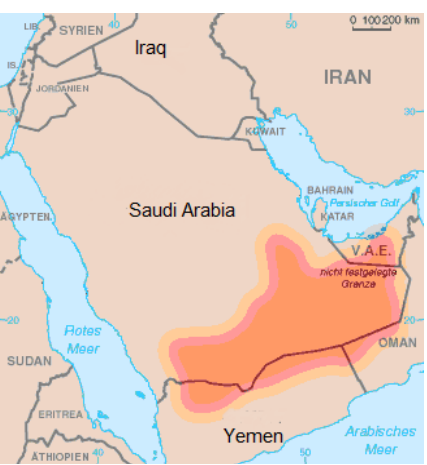
Fig. 10. Rub’al Khali (colored red) is one of the most prolific dust- producing regions of the globe. It dominates the southern parts of the Arabian